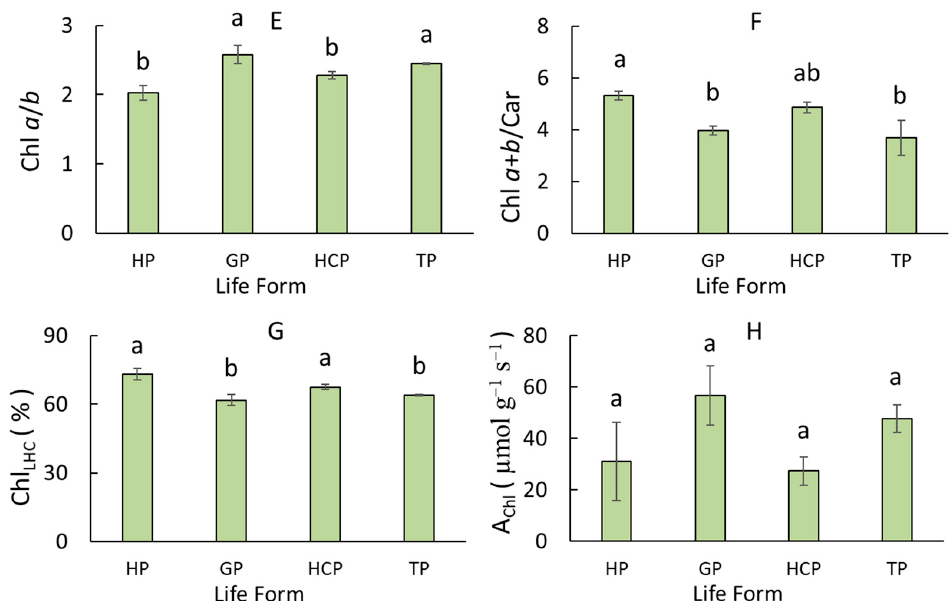
Figure 2. Leaf pigment complex traits in dicotyledonous wetland plants of different life forms (HP, helophyte; GP, geophyte; HCP, hemicryptophyte; TP, therophyte). ( A ) Chlorophyll and ( B ) carotenoid content per fresh weight. ( C ) Chlorophyll and ( D ) carotenoid content per dry weight. ( E ) Ratio of chlorophylls a and b . ( F ) Ratio of chlorophylls and carotenoids. ( G ) Proportion of chlorophyll in the light-harvesting complex. ( H ) CO 2 uptake rate per unit of chlorophyll weight. Different letters indicate significant differences between life forms ( p < 0.05). Error bars represent standard error (SE).